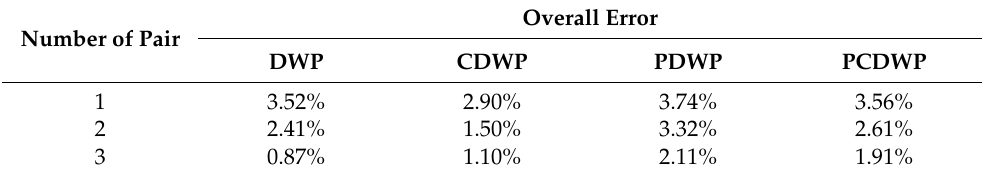
Table 4. Overall error of pressure drop for the installation of DWP, CDWP, PDWP, and PCDWP VGs. Number of